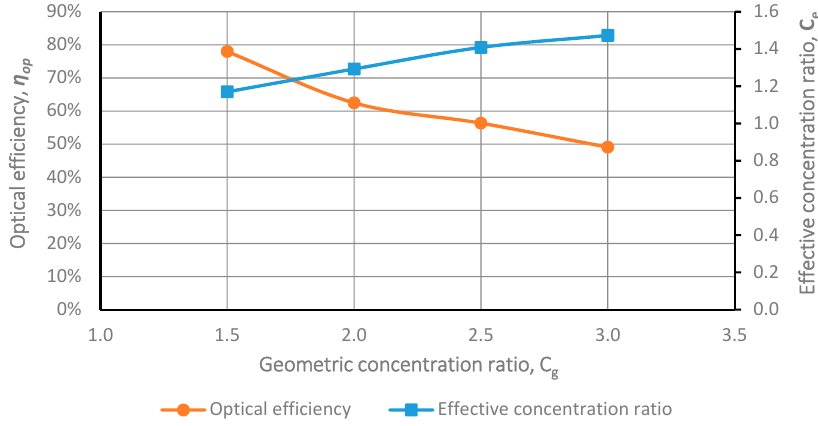
Figure 4. The optical efficiency and effective concentration ratio as a function of the geometric concentration ratio.